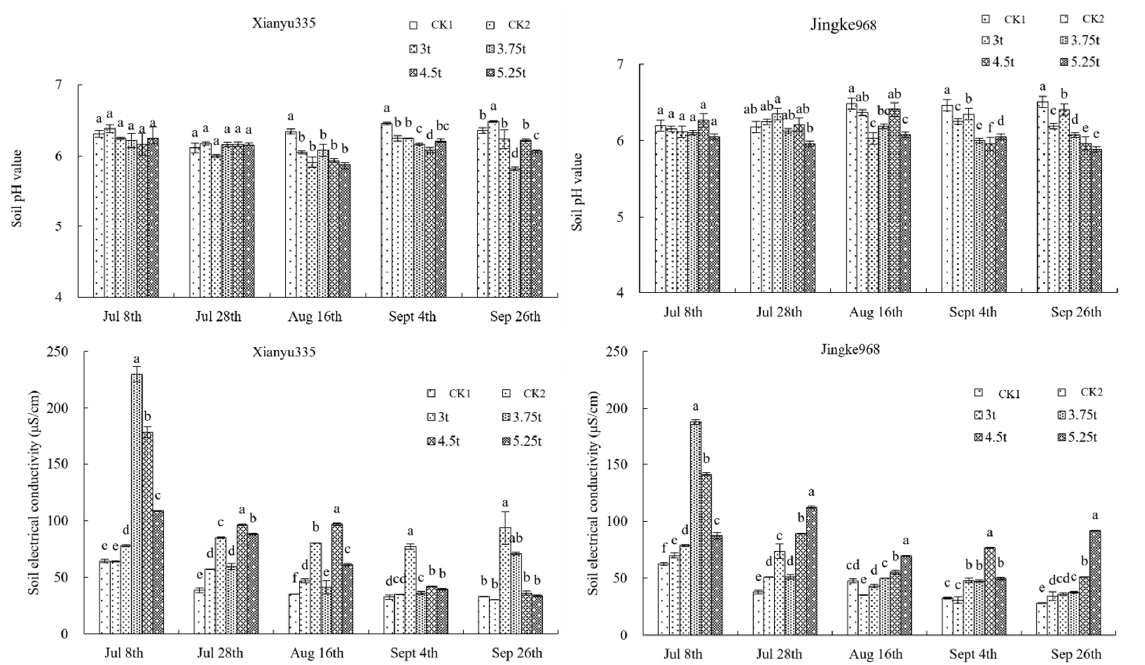
Figure 1. Effect of carbon-based fertilizer on soil pH value and soil electrical conductivity. Notes: Different letters within the same column indicate significant difference at the 5% level.